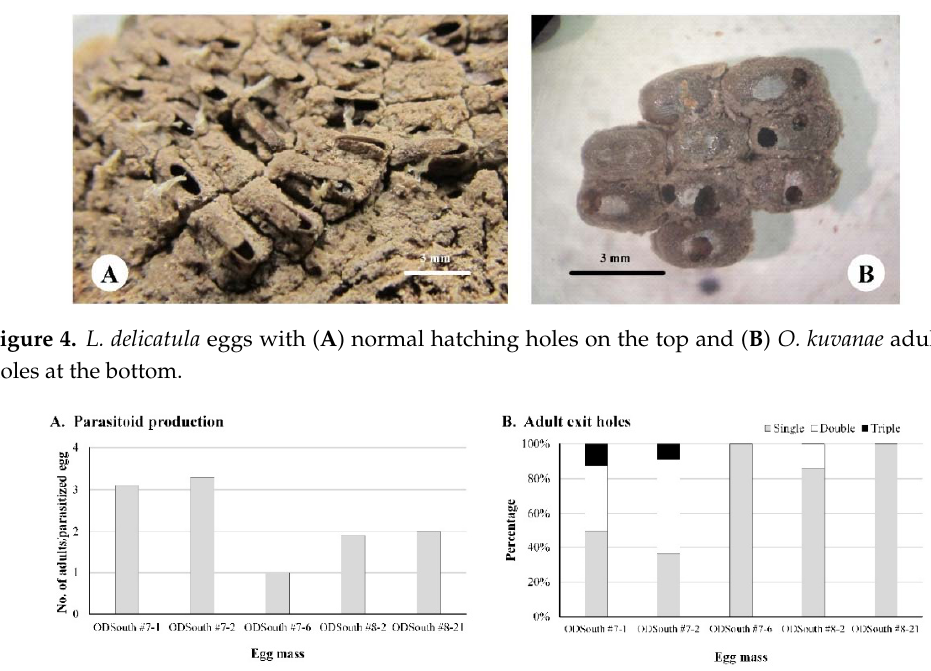
Figure 5. Superparasitism of O. kuvanae on L. delicatula eggs as indicated by (A) average parasitoid production per parasitized host egg and (B) percentage of parasitized host eggs with single/double/triple adult exit